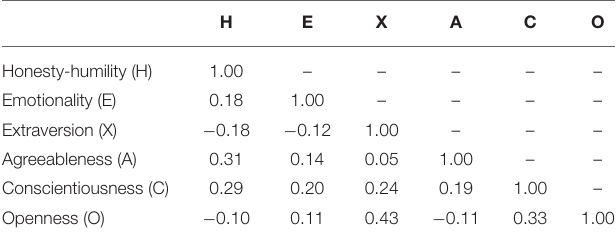
Conscientiousness